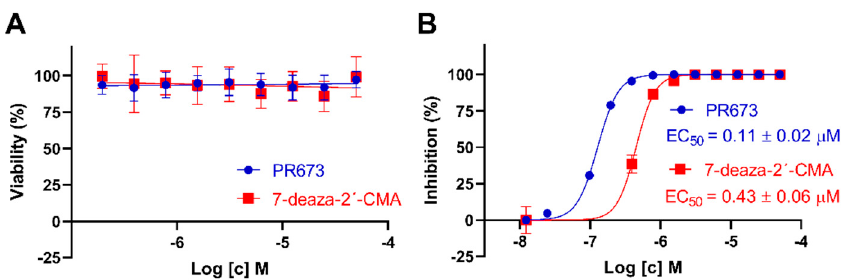
Figure 4. Cytotoxicity and anti-TBEV activity of PR673 in PS cells. ( A ) Cytotoxicity of PR673 for PS cells expressed as percentage of cell viability at the indicated drug concentrations. The cells were seeded in 96-well plates for 24 h, then treated with the compounds and incubated for 48 h. Cell viabilities were measured by Cell Counting Kit-8. ( B ) Anti-TBEV activity of PR673 in PS cells. The cell monolayers were treated with the compounds (0 to 50 µM) and infected simultaneously with TBEV (Hypr) at MOI of 0.1. The infected cells were then incubated for 48 h, after which, cell media were collected and viral titers determined using a plaque assay. The obtained titers were used to construct dose-dependent inhibition curves (as indicated) and to calculate EC 50 values. 7-deaza-2 ′ -CMA (in the same concentration range) was used as a positive control.